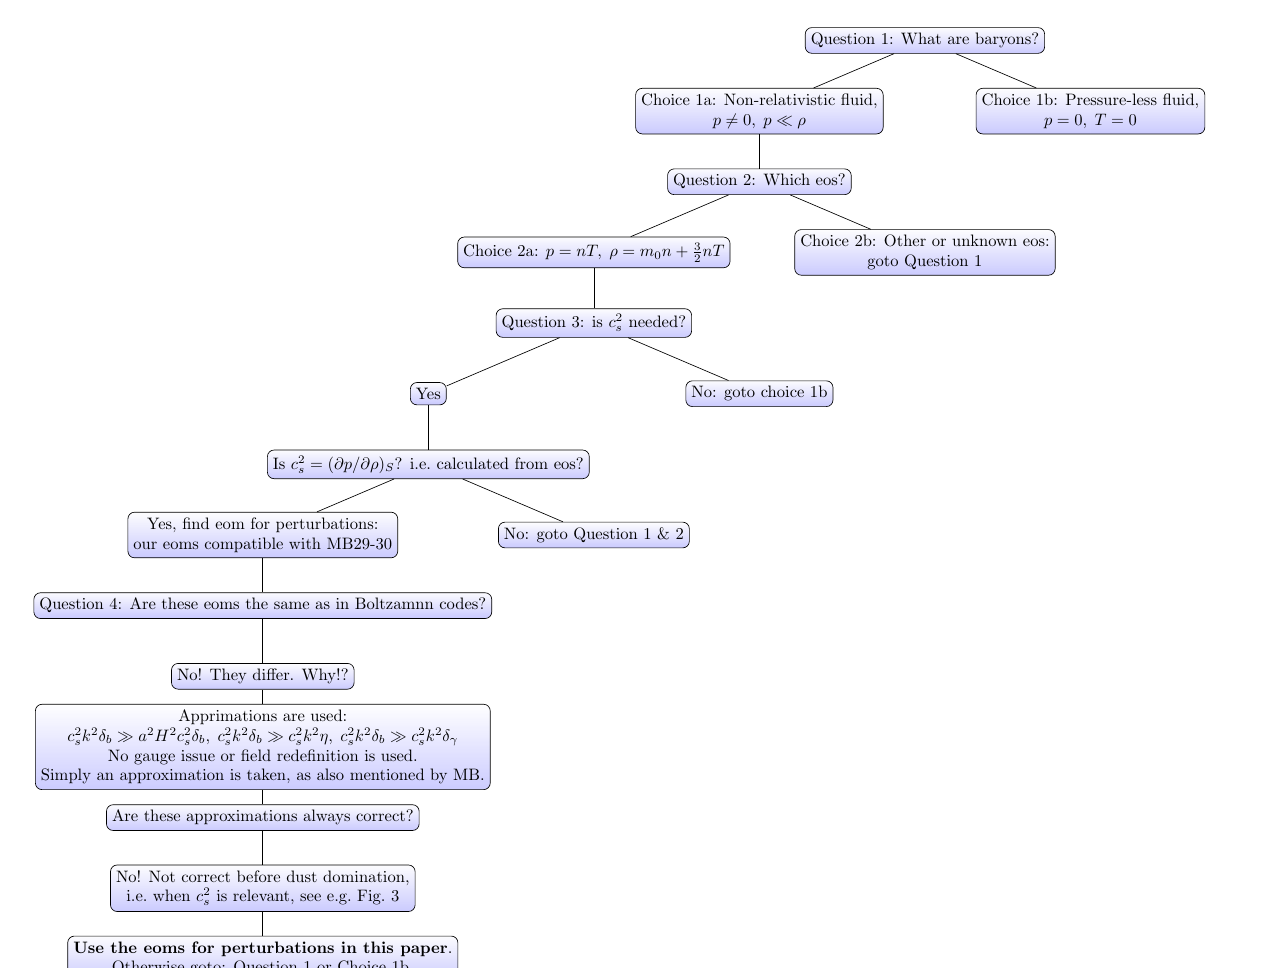
Figure 1. Tree diagram that describes the logic followed in this paper to address the issue of non-conservation of energy-momentum in the equations of motion MB66–67 for baryons in existing Boltzmann